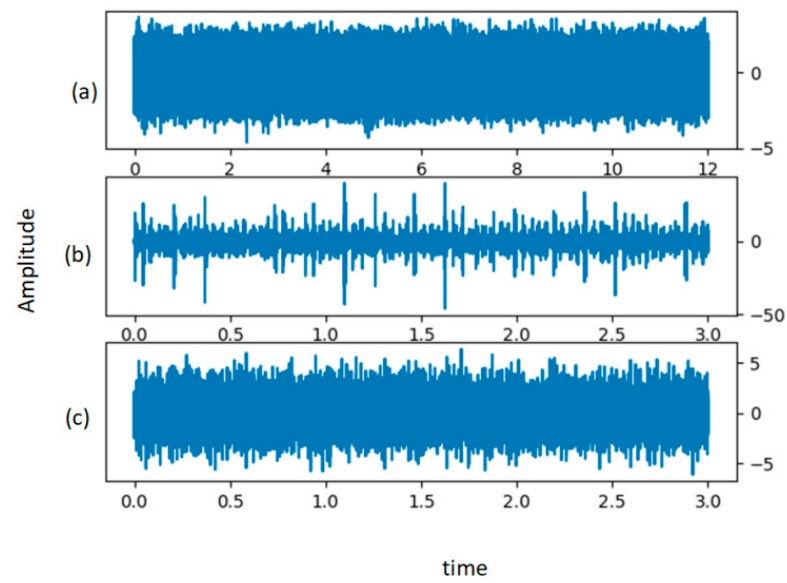
Figure 12. Raw data of groups ( a ) normal for condition, ( b ) outer, and ( c ) inner. Table 7. Description of the MFPT dataset.